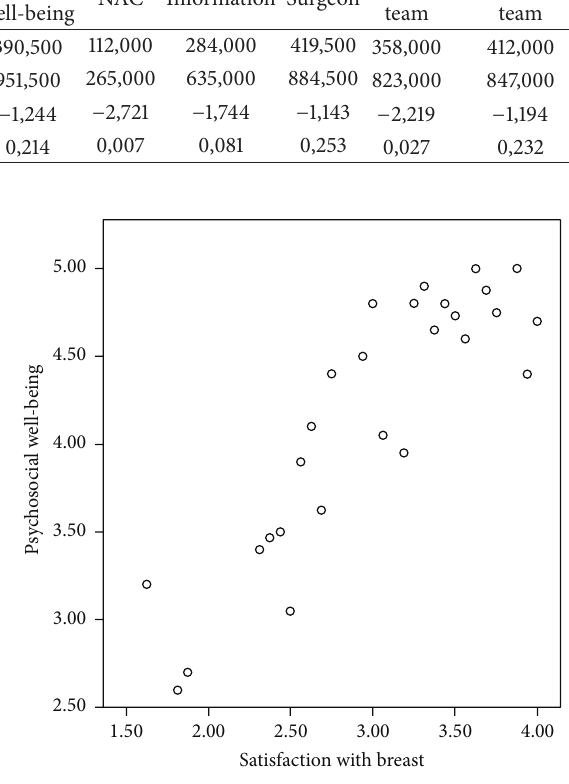
Figure 2: Correlation between reconstructed breast satisfaction and psychosocial